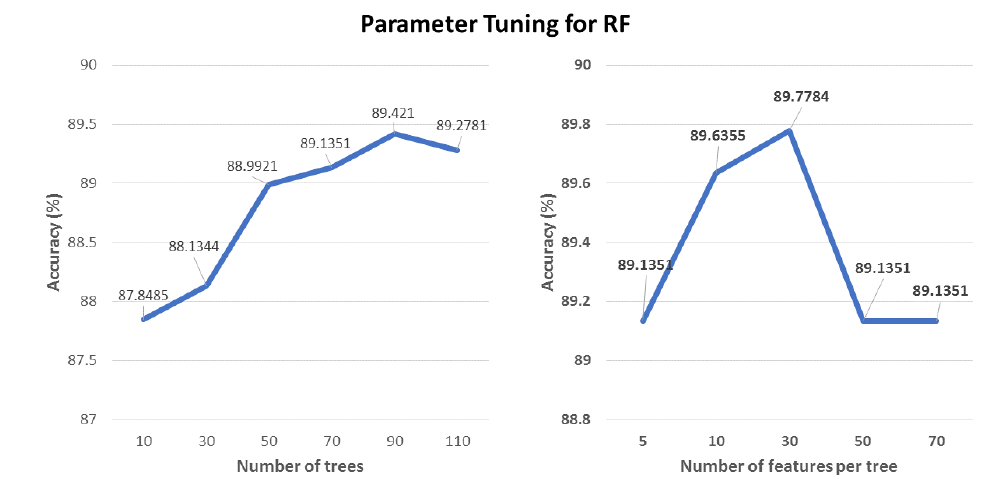
Figure 12. Parameter Tuning for RF.